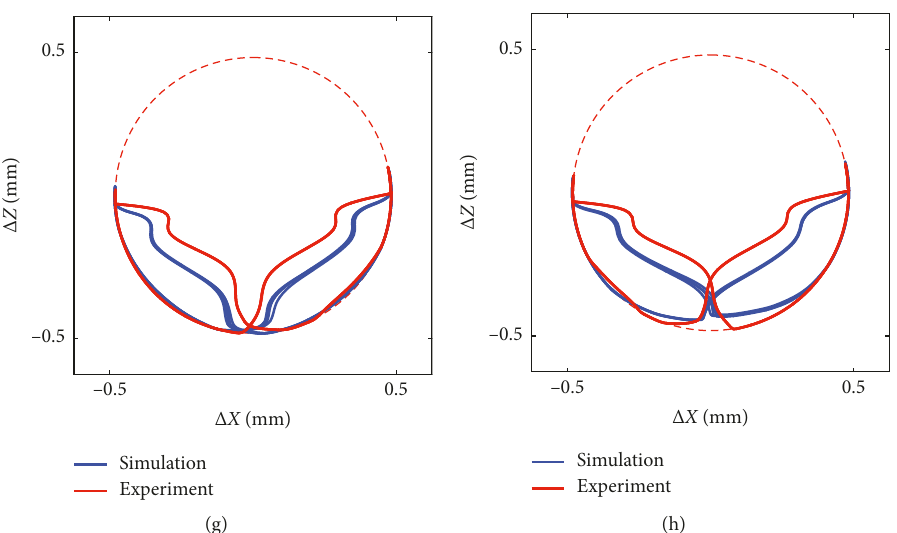
Figure 25: Trajectories in numerical and experimental studies with different frequencies: (a) left trajectories at 5Hz, (b) right trajectories at 5Hz, (c) left trajectories at 10 Hz, (d) right trajectories at 10Hz, (e) left trajectories at 15Hz, (f) right trajectories at 15Hz, (g) left trajectories at 20Hz, and (h) right trajectories at 20Hz.